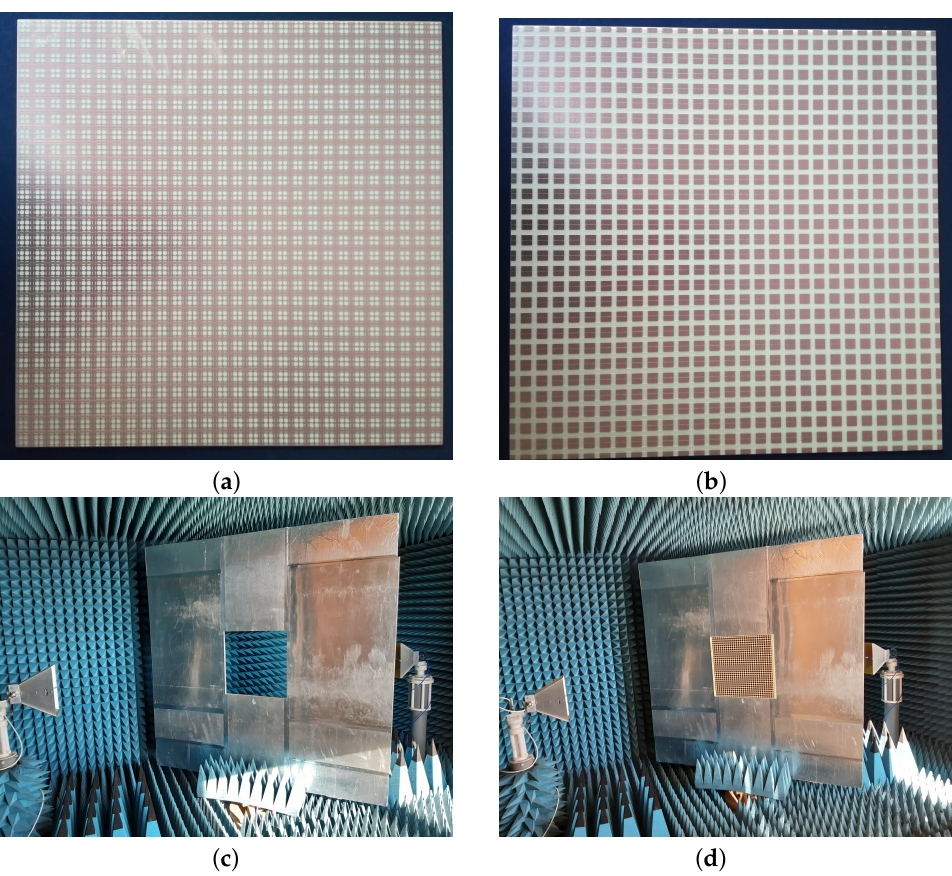
Figure 9. Experimental validation: PCB prototype Face 1 ( a ), and Face 2 ( b ); measurement setup without ( c ), and with ( d ) prototype inserted.